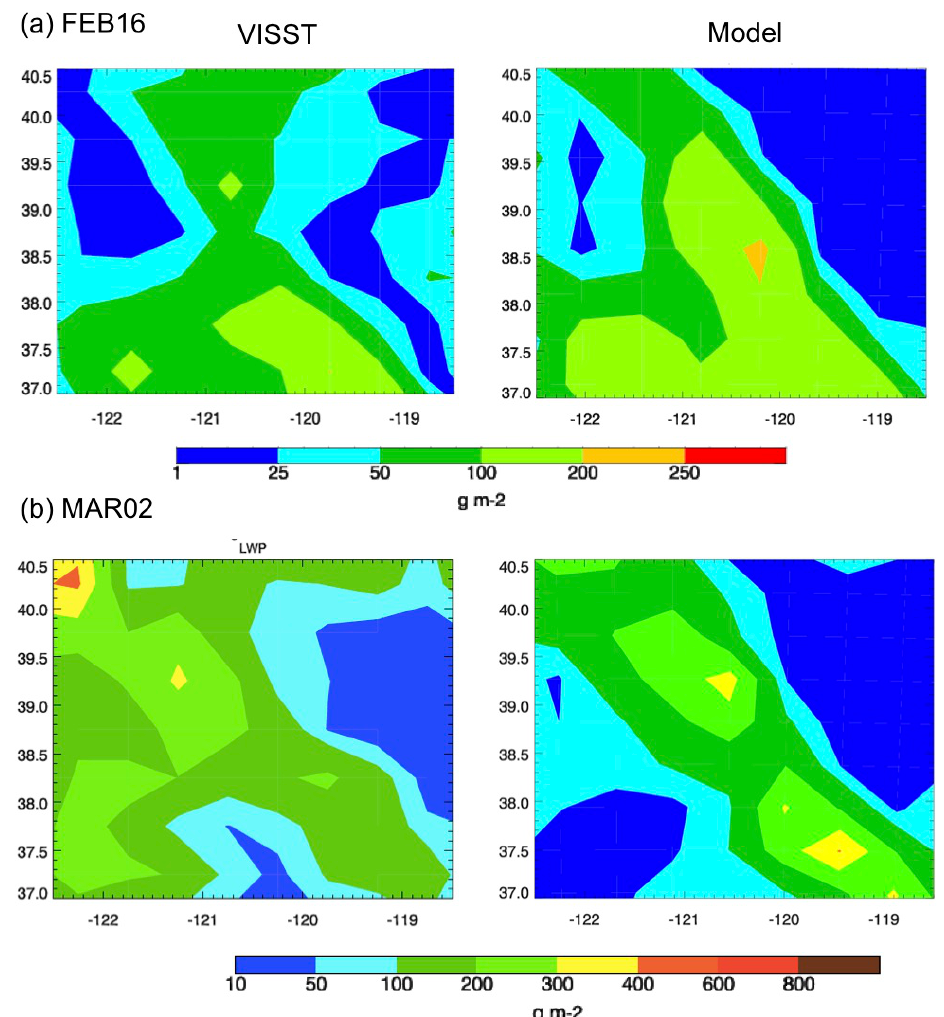
Fig. 6. Comparison of the modeled LWP from the base run (LoCCN&Dust) with the VISST observations for (a) FEB16 and (b) MAR02. LWP is averaged over the time from 12:00–23:00UTC of the day when the solar zenith angle ( θ ) is less than 80 ◦ , since the observational data are only good with θ <80degree and there are no observations at some hours during 00:00–12:00UTC. Both model and observations are hourly data. The model values are averaged over the 50km scale for comparison with the VISST data grid scale of 0.5 ◦ at the